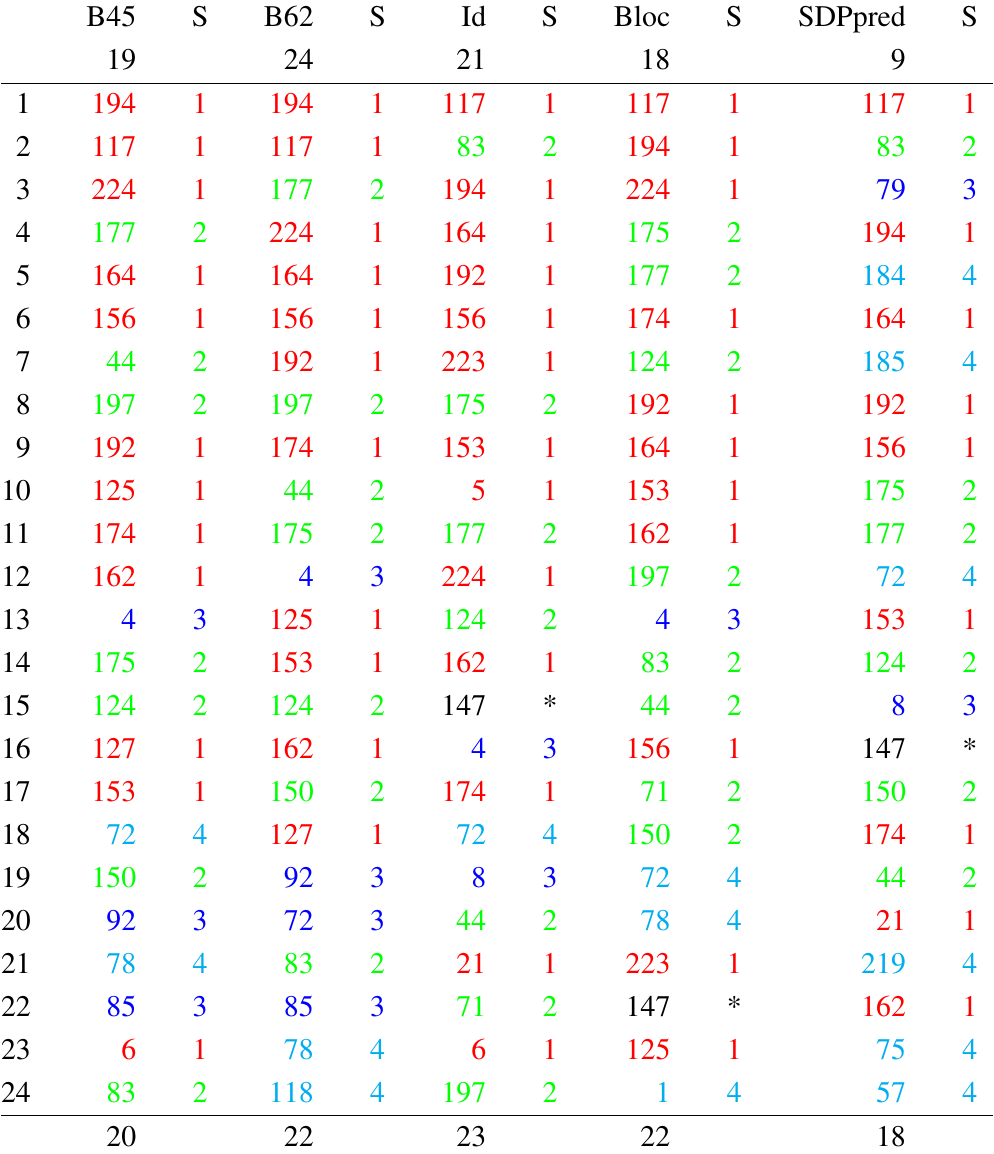
Table 5. The 24 best ranking SDPs inferred from 92 mono- and multimeric IFP members; next 16 SDPs can be found in SI. Column labeling as in Table 1. Numbering refers to the DsRed sequence (1GGX PDB code). The first row reports the number of statistically signifi- cant positions. The meaning of the interspersed score columns, S , is detailed in the main text, as well as the description of the peculiar role of position 147. Different scores colored as in Table 1. The last row of the panel reports how many of the 33 experimentally sanctioned po- sitions ranked between 1 and 33 in the corresponding run. Each run, comprising N = 10000 shuffles, required about 20 minutes on a 2.13GHz INTEL R (cid:176) PENTIUM R (cid:176) processor with 2GB of